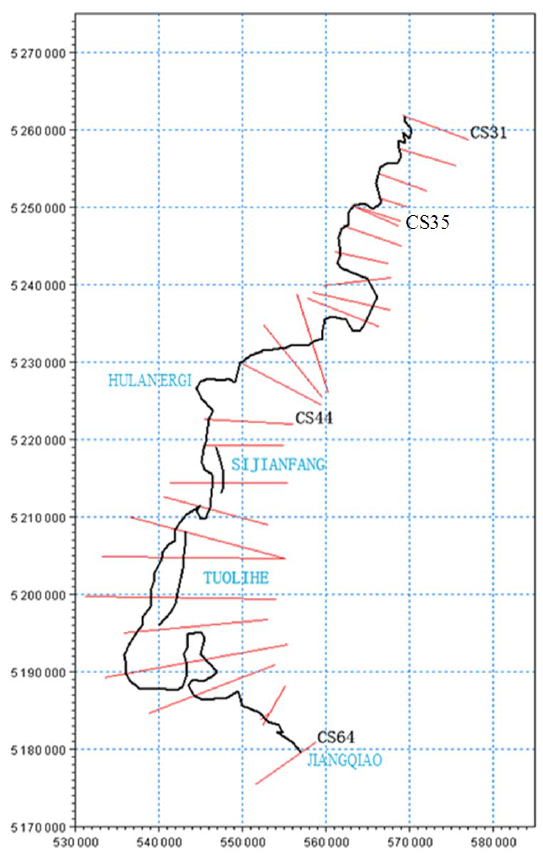
Figure 6. Main sections of one-dimensional model.